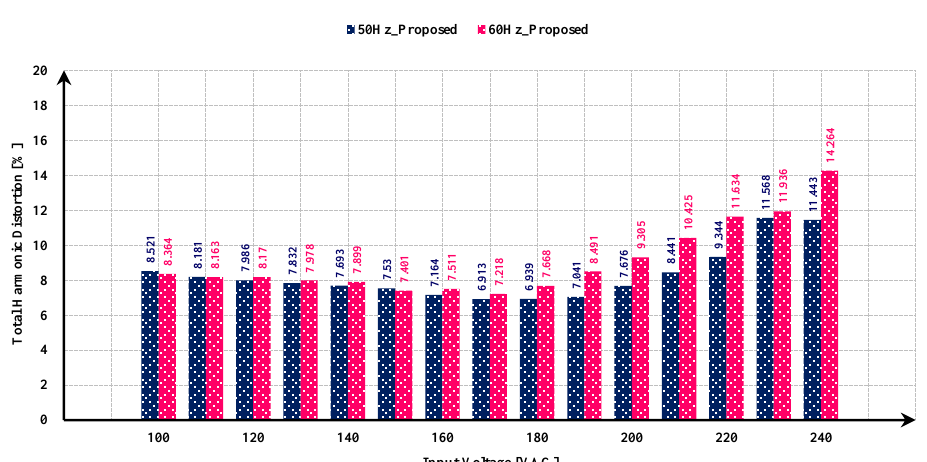
Figure 11. Total harmonic distortion (THD) according to the input voltage.